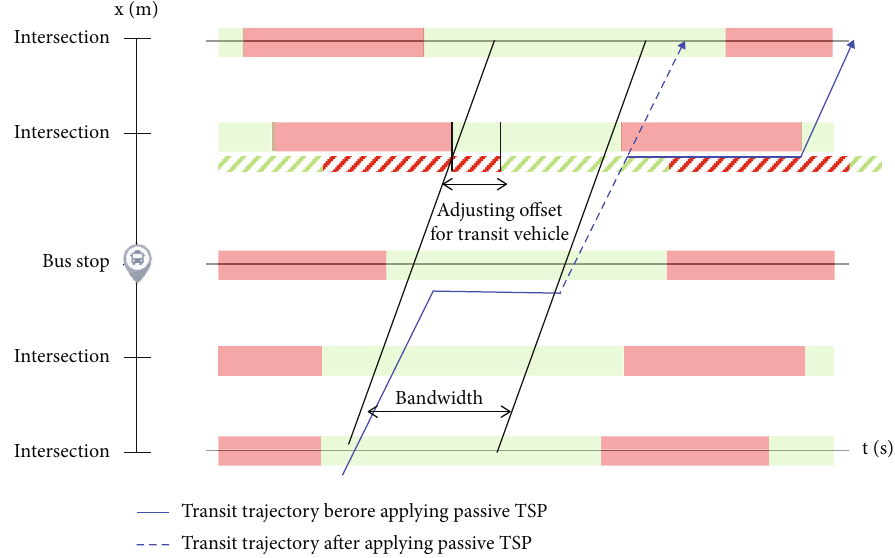
Figure 1: Transit-vehicle trajectory before and after application of simple passive transit-signal priority (TSP).